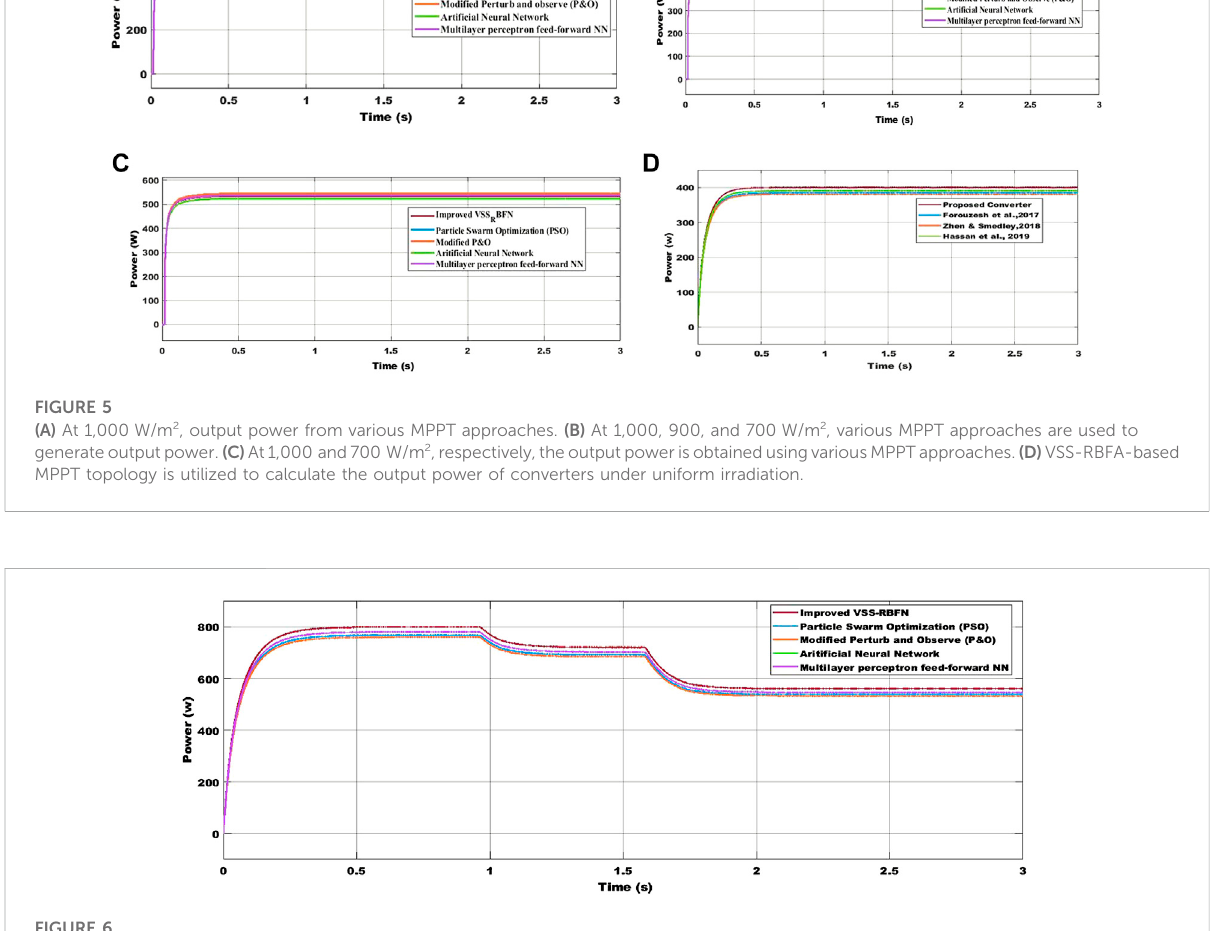
FIGURE 6 At fast-changing irradiation conditions, output power using various MPPT